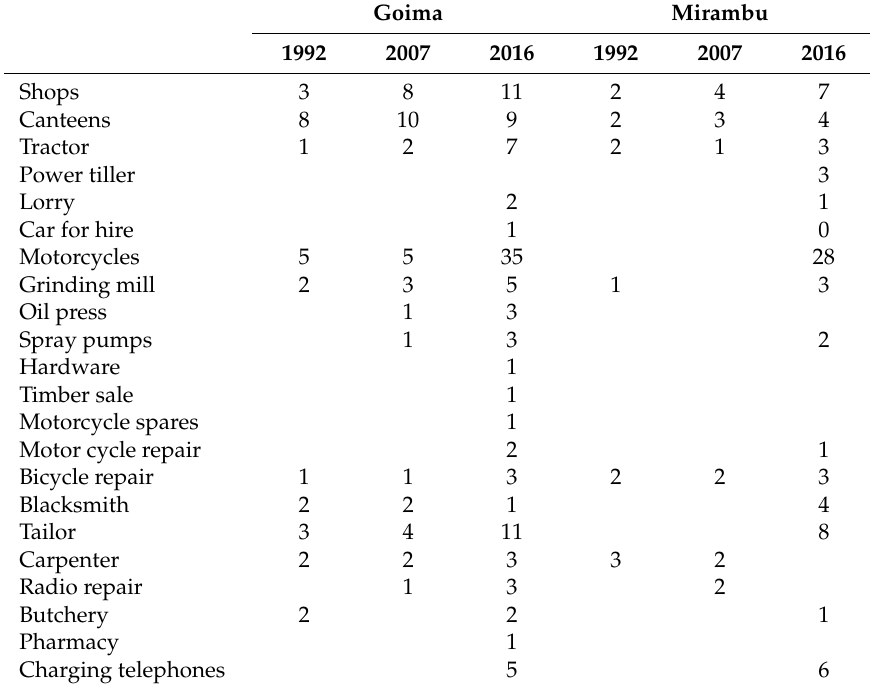
Table 2. Commerce and Infrastructure